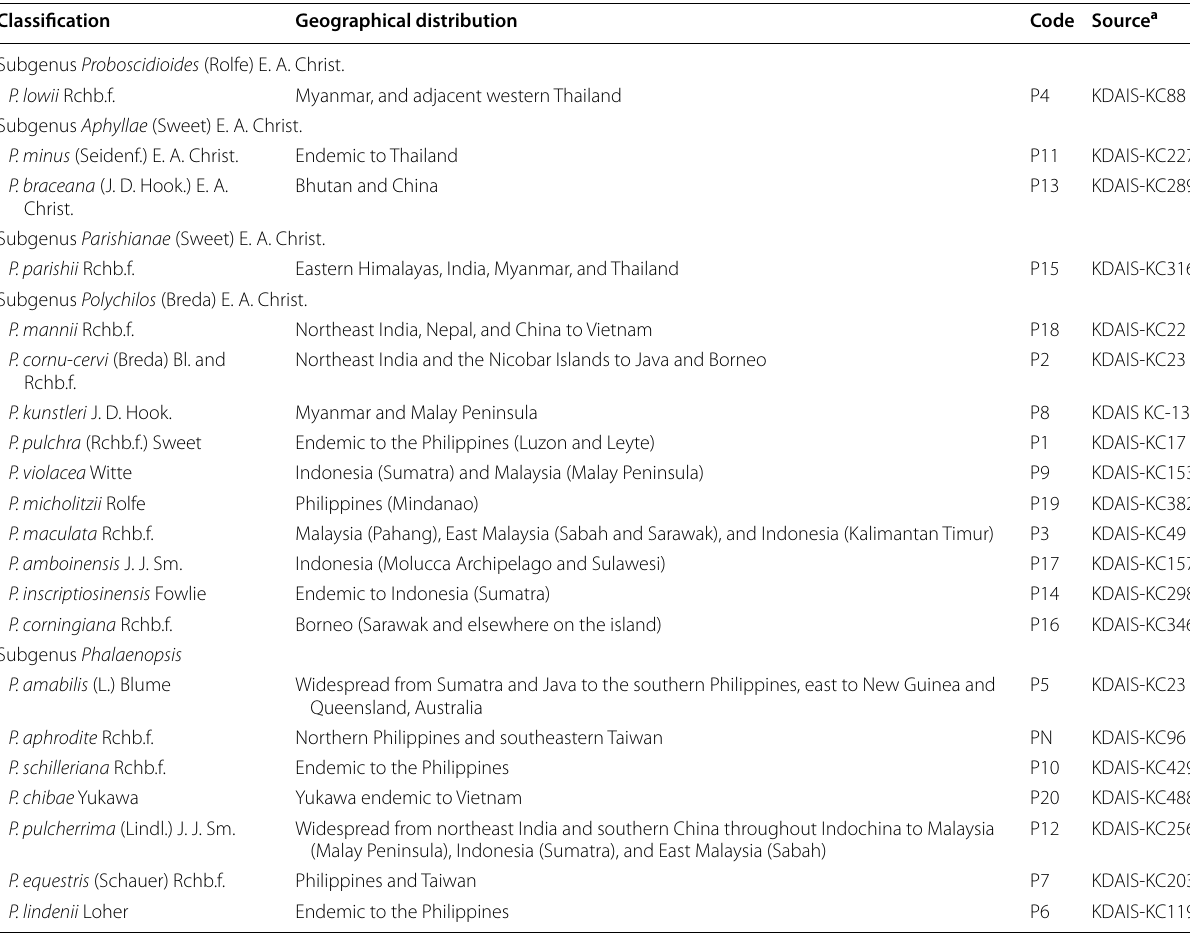
Table 1 Information on geographic distribution, species code and voucher specimens of the genus Phalaenopsis used in this